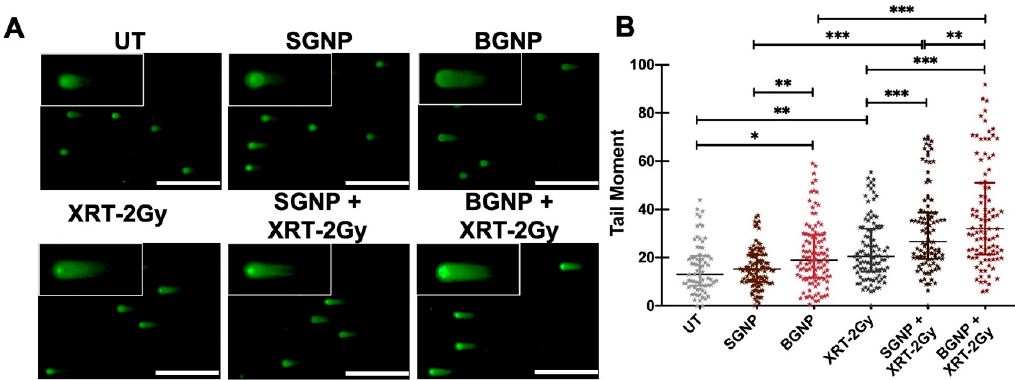
Figure 2. Neutral comet assay for LLC cells. Cells were untreated (UT), treated with small gold nanoparticles (SGNP) or big gold nanoparticles (BGNP), 2 Gy X-ray irradiation (XRT-2 Gy), or a combination of 2 Gy and either small or big gold nanoparticles. ( A ) Scale bar represents 400 μ m. ( B ) The horizontal line shows the median and the vertical line shows the interquartile range. At least 50 random cells were scored per sample. A one-way ANOVA was performed to determine statistical significance (* p < 0.033, ** p < 0.002, and *** p < 0.001).